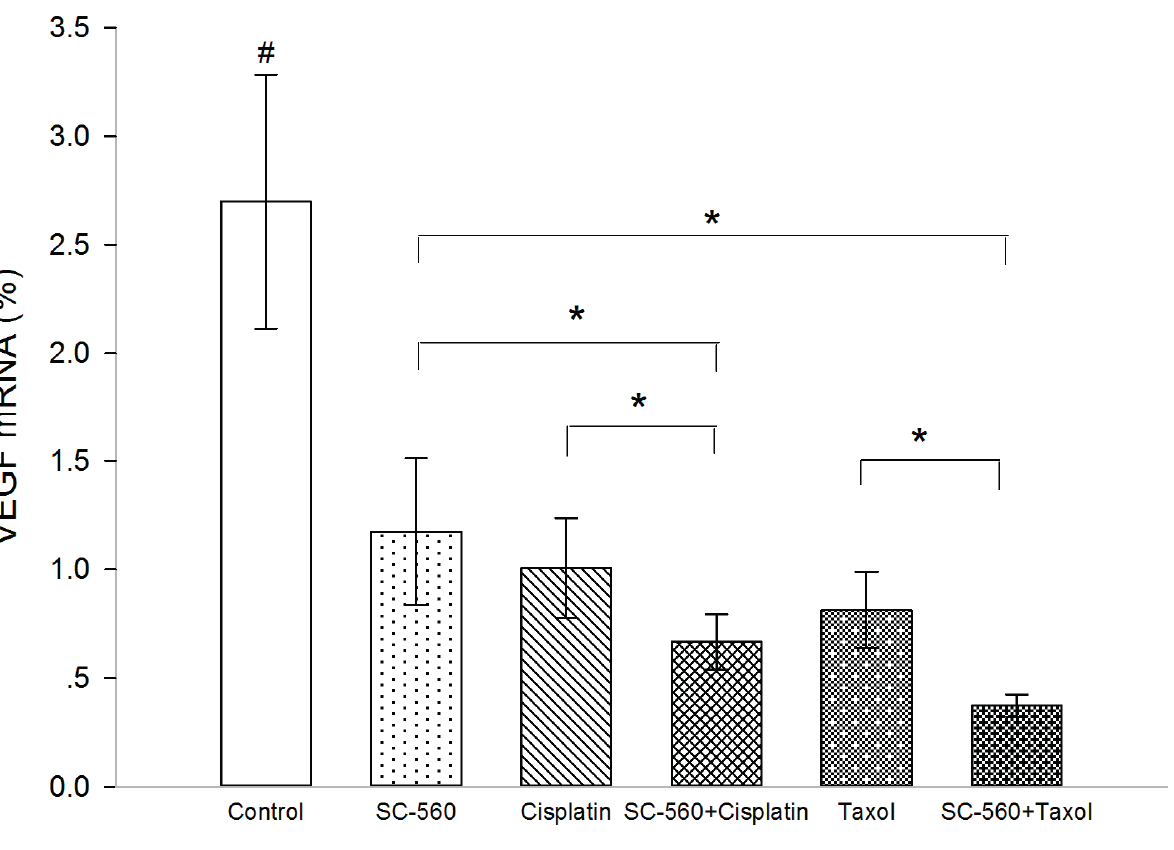
Figure 6. Effects of the drugs on the expression of VEGF mRNA. # VEGF mRNA expression levels of treatment groups compared with control group, p < 0.05 for all; * p < 0.05; error bars indicate standard error.